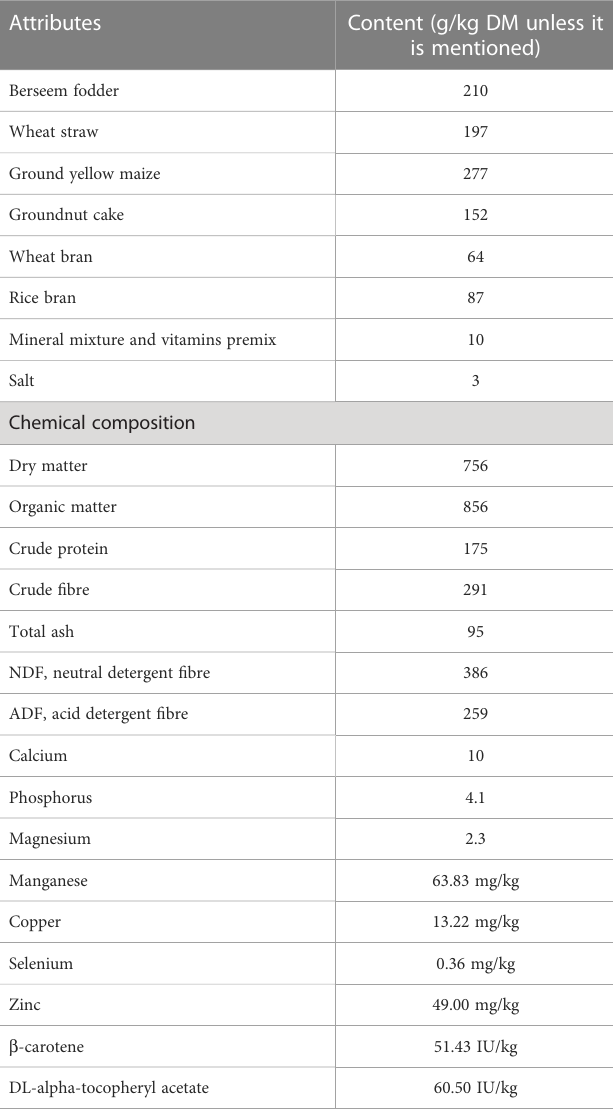
TABLE 1 Attributes and chemical composition of total mixed ration (TMR) fed during the experimental period.